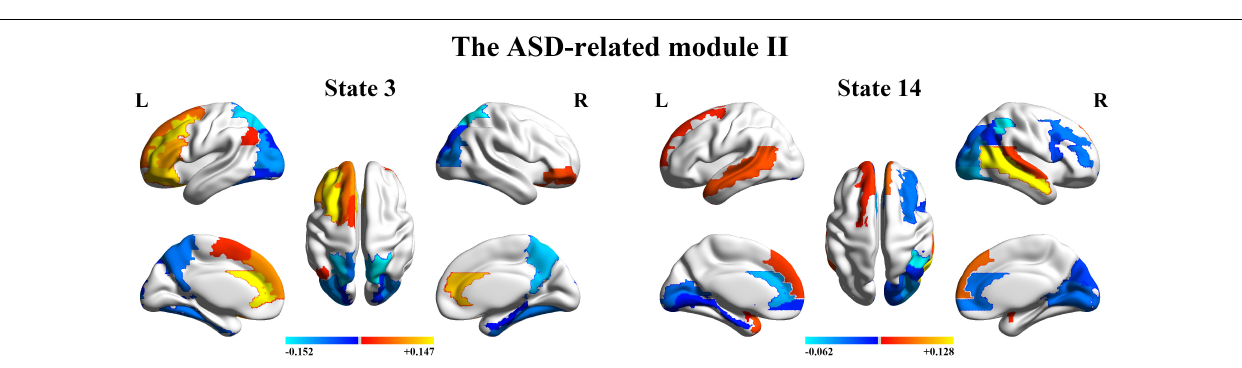
FIGURE 6 | The mean activation maps for states 2 and 17 in the ASD-related module I.